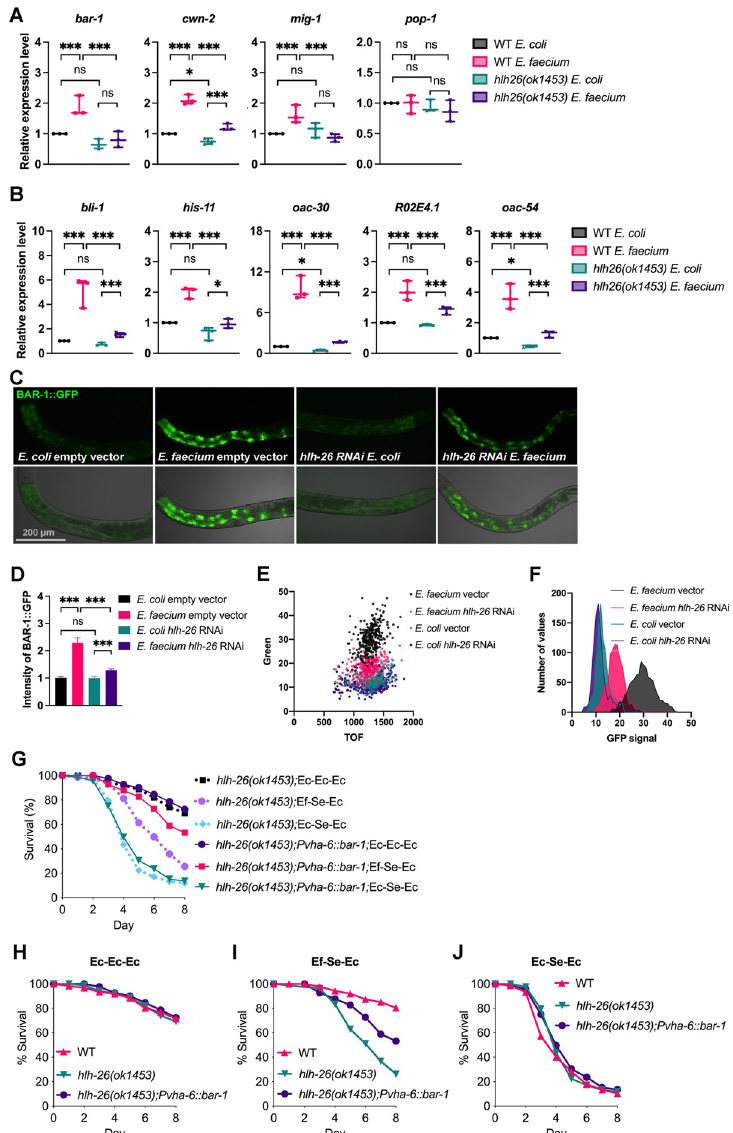
Fig 6. HLH-26 is required for probiotic protection against S . enterica infection by regulating the canonical Wnt/ BAR-1 pathway. (A) qRT-PCR validation of Wnt component genes ( N = 3 biological replicates). Values are expressed as the fold difference compared with wild-type worms fed on E . coli ± SD by one-way ANOVA with Tukey’s multiple comparisons test, � P < 0.05, �� P < 0.01, ��� P < 0.001. (B) qRT-PCR validation of overlapping genes from Wnt targets and hlh-26 –down-regulated genes ( N = 3 biological replicates). Values are expressed as the fold difference compared with wild-type worms fed on E . coli ± SD by one-way ANOVA with Tukey’s multiple comparisons test, � P < 0.05, �� P < 0.01, ��� P < 0.001. (C) Fluorescence micrographs of control or hlh-26 RNAi animals expressing GFP fused to BAR-1 (BAR-1::GFP) after a 24-h exposure to E . faecium or E . coli . (D) Quantification of the animals shown in (C), N = 3 biological replicates. � P < 0.05, �� P < 0.01, ��� P < 0.001. (E) Dot-plot representation of green fluorescence intensity versus TOF of vector or hlh-26 RNAi animals exposed to E . faecium or E . coli ( n = 300). (F) Frequency distribution of the green fluorescence of vector or hlh-26 RNAi animals exposed to E . faecium or E . coli . Three independent experiments were performed. E . coli vector versus E . coli hlh-26 RNAi, P = NS; E . coli vector versus E . faecium vector, P < 0.001; E . faecium vector versus E . faecium hlh-26 RNAi, P < 0.001. (G) Comparation of E . faecium –mediated protection between hlh-26(ok1453) animals and hlh-26(ok1453); Pvha-6 :: bar-1 rescue animals. hlh- 26(ok1453) ; Ec-Ec-Ec versus hlh-26(ok1453); Pvha-6 :: bar-1 ;Ec-Ec-Ec, P = NS; hlh-26(ok1453) ; Ef-Se-Ec versus hlh-26 (ok1453); Pvha-6 :: bar-1 ; Ef-Se-Ec, P < 0.0001; hlh-26(ok1453) ; Ec-Se-Ec versus hlh-26(ok1453); Pvha-6 :: bar-1 ; Ec-Se- Ec, P = NS. (H) WT, hlh-26(ok1453) , and hlh-26(ok1453); Pvha-6 :: bar-1 animals were grown with Ec-Ec-Ec treatment and scored for survival. WT animals versus hlh-26(ok1453) , P = NS; hlh-26(ok1453); Pvha-6 :: bar-1 , P = NS. (I)